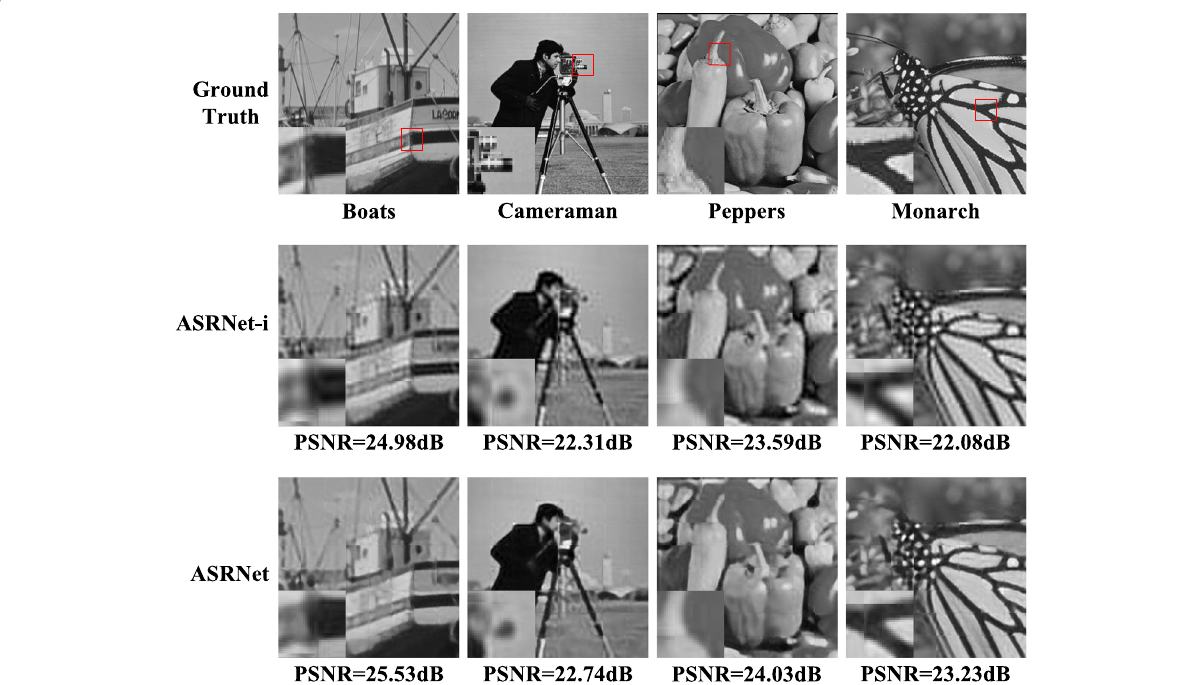
Fig. 19 The intermediate and final reconstruction results of ASRNet at the measurement rate 0.04